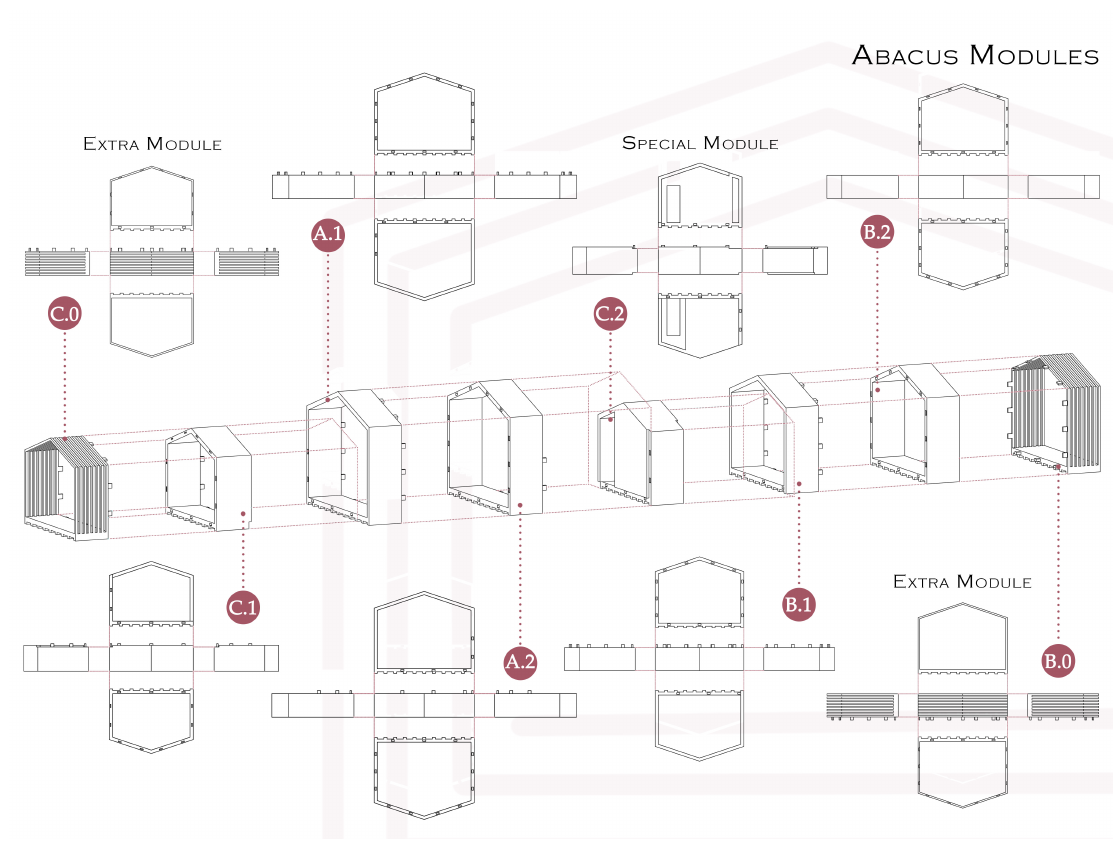
Figure 3. Axonometric projection of MoDom modules.